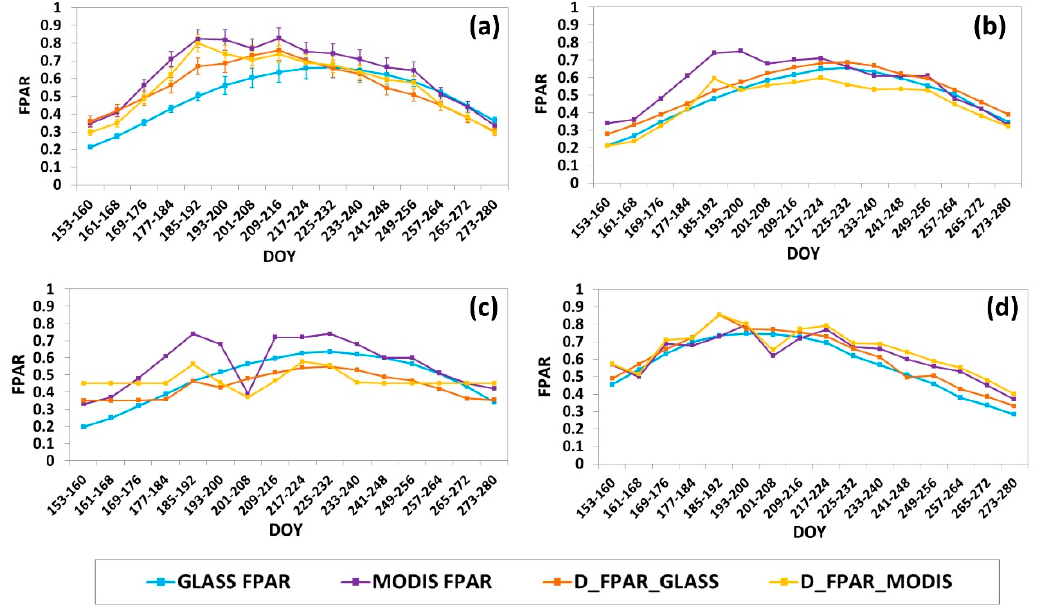
Figure 8. Comparison of MODIS FPAR, GLASS FPAR, D_FPAR_GLASS and D_FPAR_MODIS: ( a ) Cropland; ( b ) orchard; ( c ) vegetable field; ( d ) wetland. Note that the FPAR are the mean values of pixels from all sites in cropland.